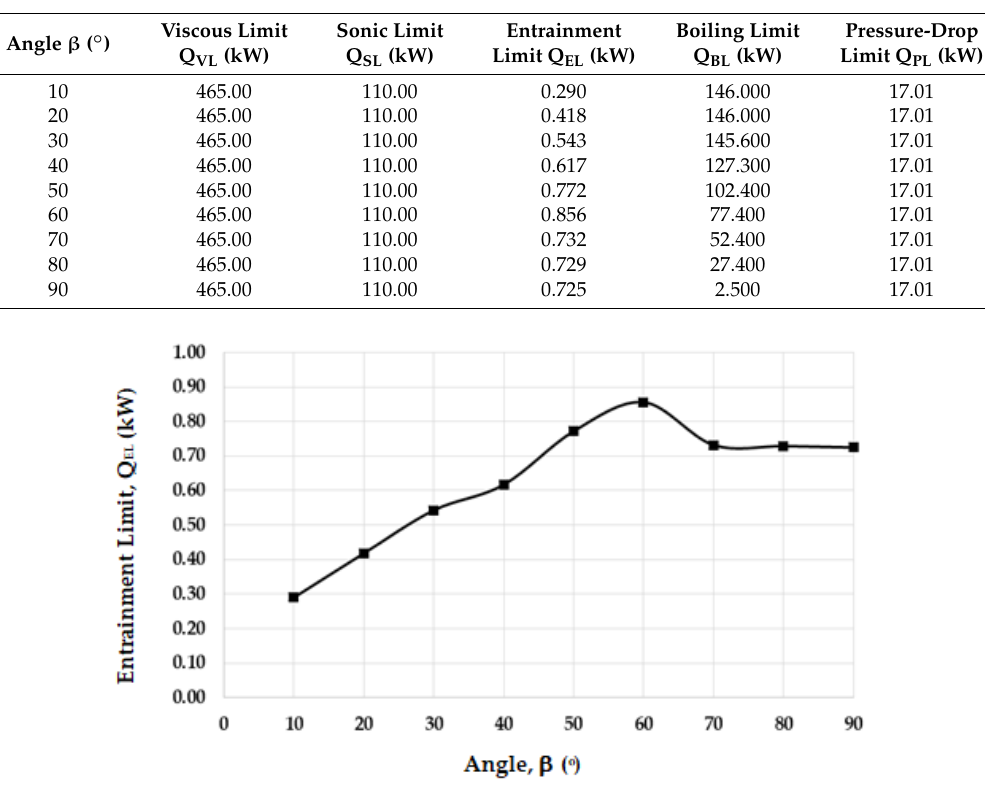
Figure 6. Impact of the evaporator inclination angle on the entrainment limit.